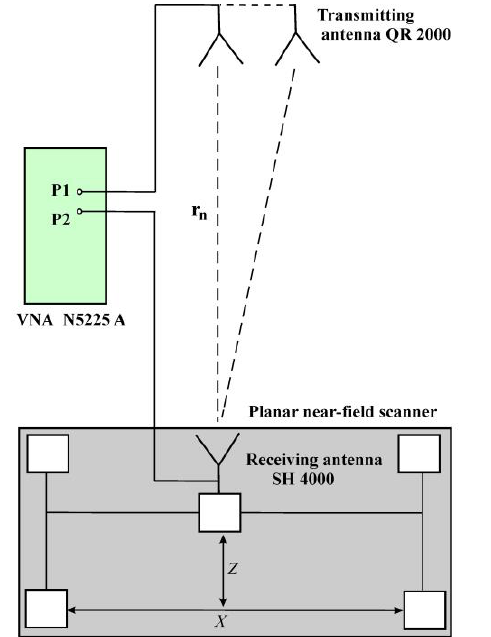
Fig. 1. Schematic of the experimental system in anechoic chamber.